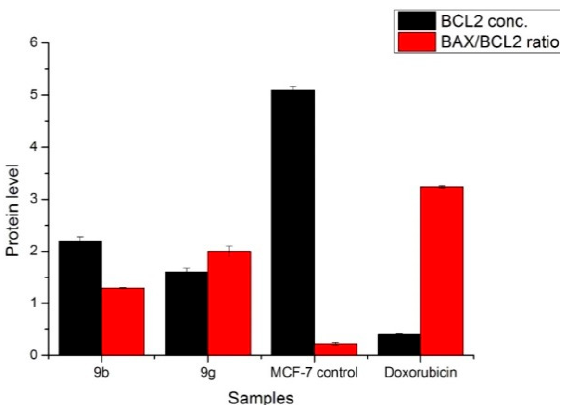
Figure 3. Bcl2 protein level (ng / mL) and BAX / BCL2 ratio of MCF-7treated with IC 50 of compound 9b (19.8 µ g / mL) and IC 50 of 9g (26.2 µ g / mL) compared to untreated cells and cells treated with reference drug Doxorubicin. p < 0.05 in 9b and 9g . Table 1. BAX protein level (Pg / mL) of MCF-7treated with IC 50 of compound 9b (19.8 µ g / mL) and IC 50 of 9g (26.2 µ g / mL) compared to untreated cells and cells treated with reference drug Doxorubicin. BAX CONC. 9b 160.5 9g 241.7 cont. 40.743 Doxorubicin 259.2